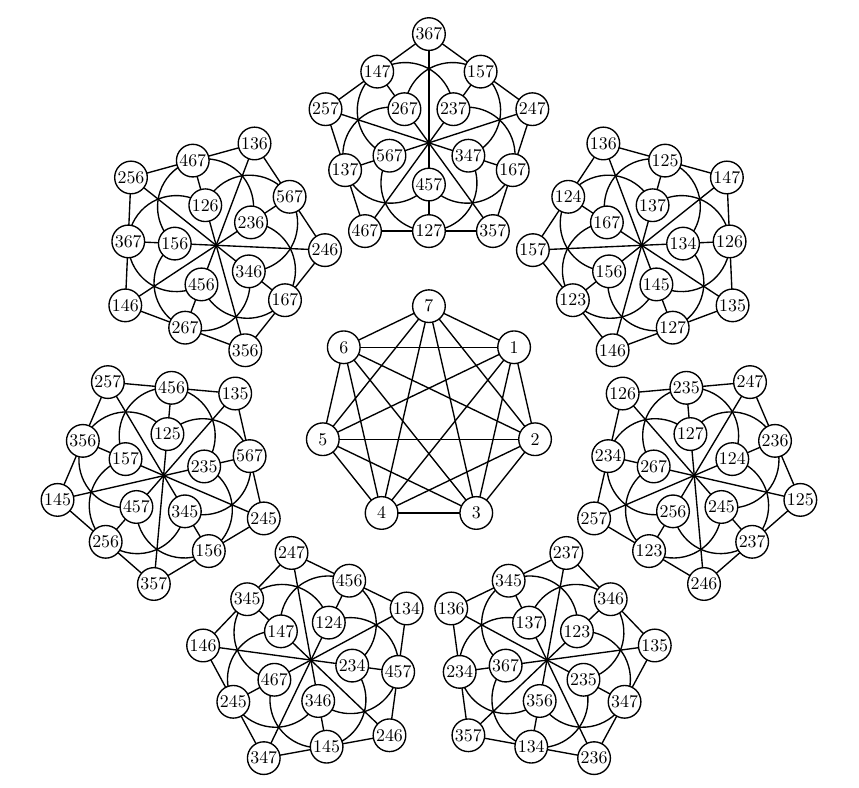
Figure 8. An abstract heptad of doilies on a seven-element